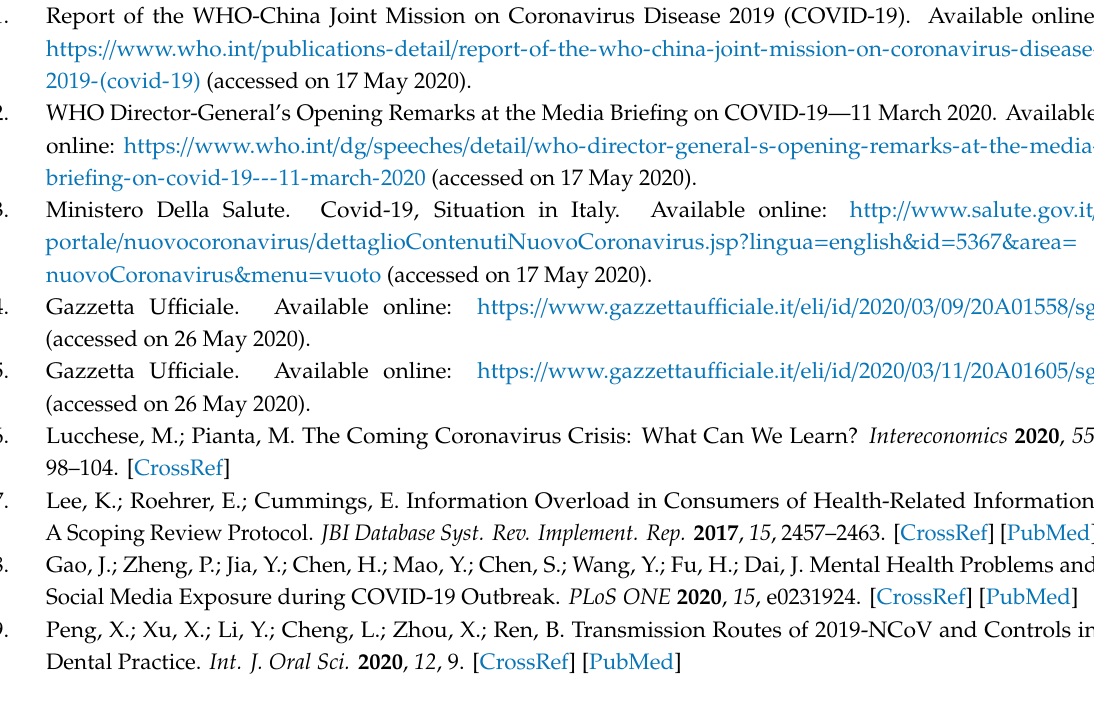
Table S1: Questionnaire used in order to analyze the Italian patient’s anxiety, concerns or willingness to undergo dental care treatments after SARS-CoV-2. This is the English version of the original questionnaire in Italian language. Table S2: Creation and definition of new variables used for statistical